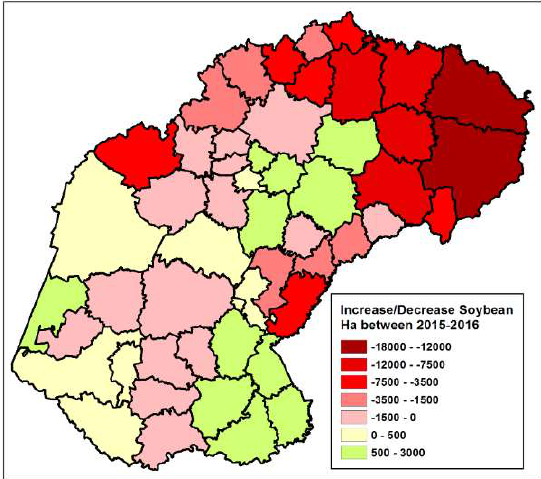
Figure 15. Calculated increase or decrease in area (Ha) of soybeans cultivated in 2015 and 2016 in Freestate The change in soybeans cultivated per district in the Freestate also presents an interesting picture. Between 2014 and 2015 the greatest increase for a district was almost 35 000 hectares. The highest reduction was only about 6000 Ha in a district.